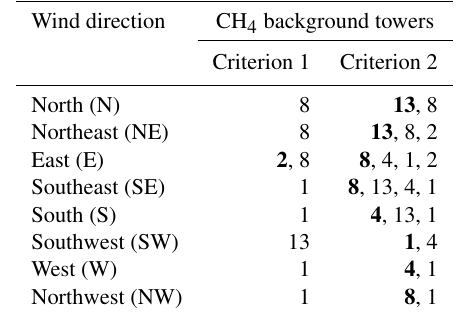
Table 1. INFLUX towers used to estimate CH 4 background based on two different criteria. Numbers in bold indicate towers chosen to generate a background field when multiple options are possible (for more details see discussion). In short, criterion 1 uses towers with the lowest mean CH 4 for a specific wind direction, and criterion 2 uses towers outside of Marion County and not downwind of large sources (including the city as a